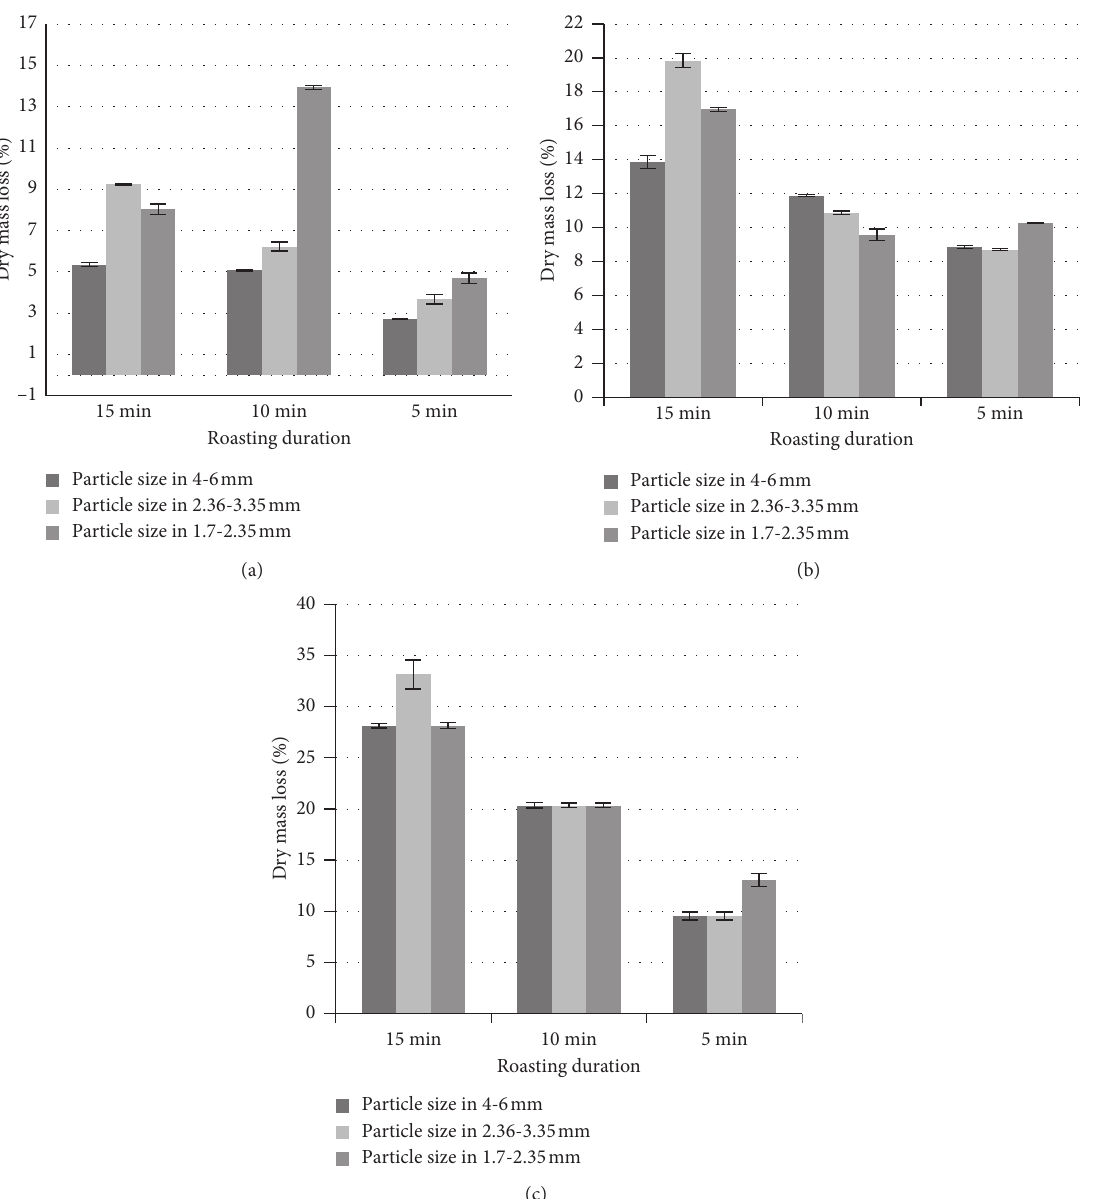
Figure 2: Effect of bean particle size, roasting temperature, and time on the dry mass loss (%) of roasted coffee beans. (a) Roasting temperature at 200 ° C. (b) Roasting temperature at 230 ° C. (c) Roasting temperature at 260 °